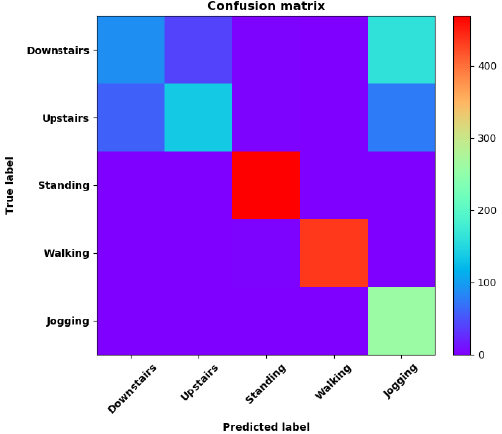
Figure 21. Confusion matrix of classification test using the model trained by CNN network.